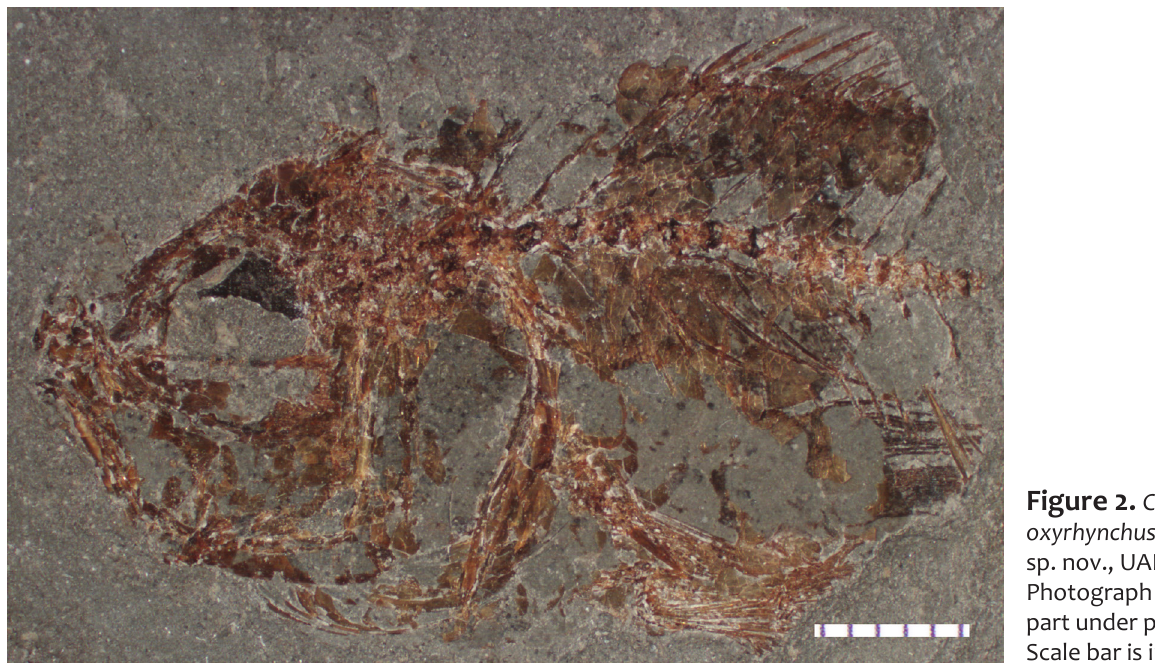
Figure 2. Cumbaaichthys oxyrhynchus gen. et sp. nov., UALVP 56113. Photograph of the counter- part under polarized light. Scale bar is in mm